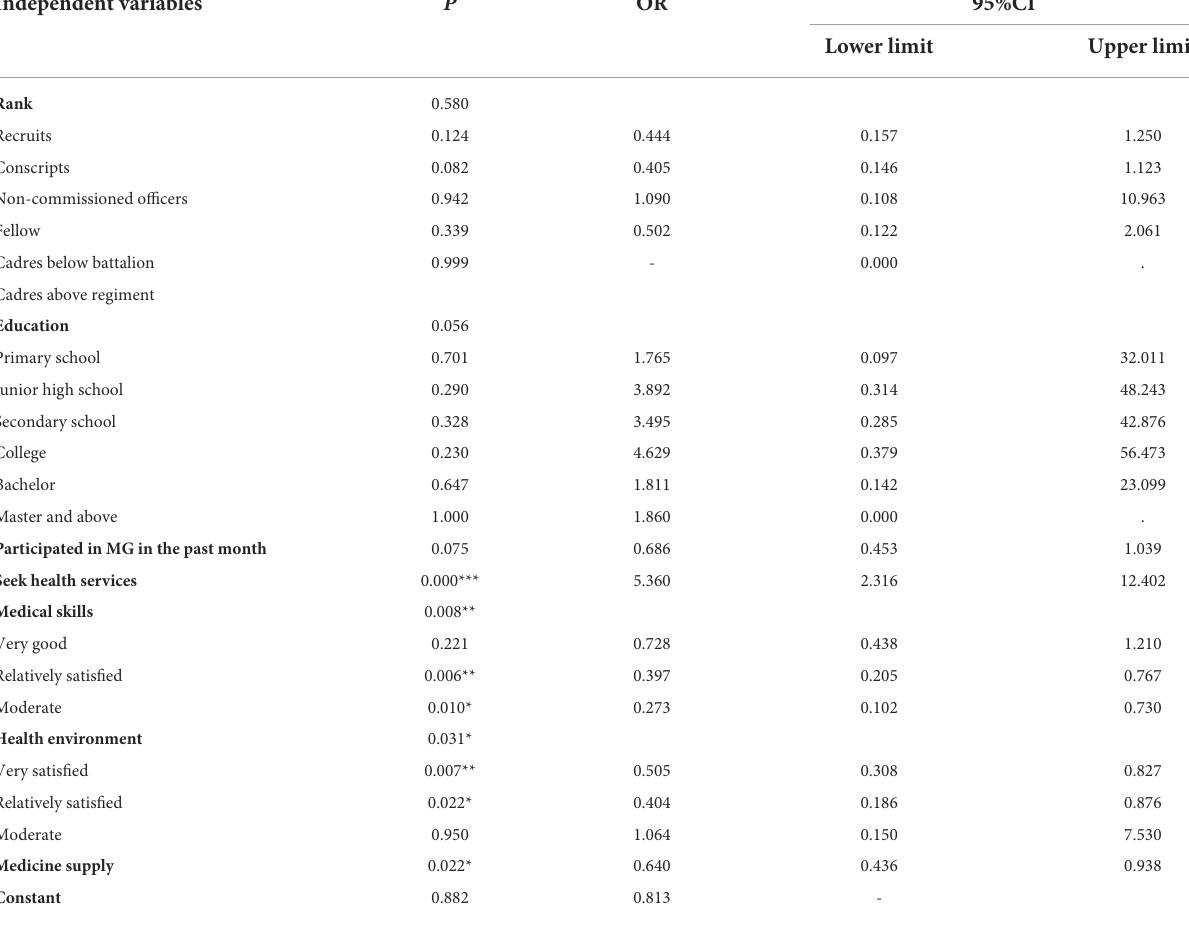
TABLE 3 Binary logistic regression analysis of PAP personnel’s stress exposure status. Independent